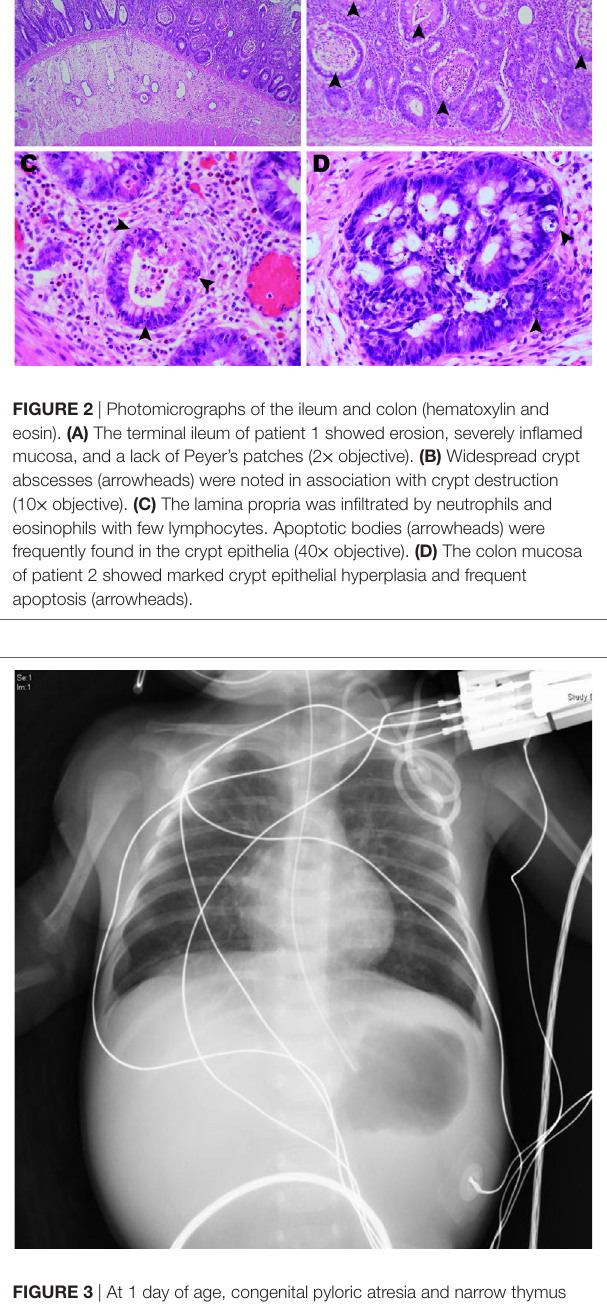
FigUre 3 | At 1 day of age, congenital pyloric atresia and narrow thymus shadow in her middle mediastinum were noted on a plain X-ray.